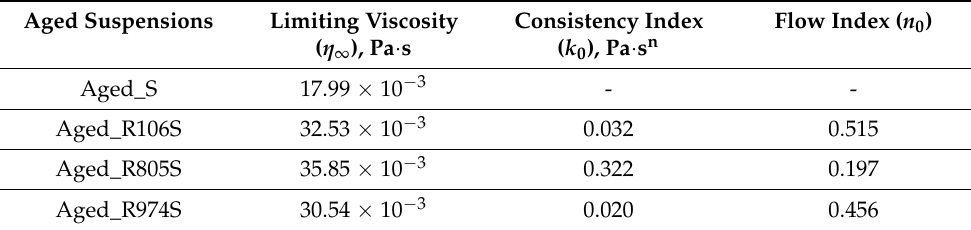
Figure 6. Effect of aging on the pseudoplasticity of HFS suspensions at 60 °C (solid lines represent the Sisko model). Table 6. Effect of aging on the parameters of the Sisko model.